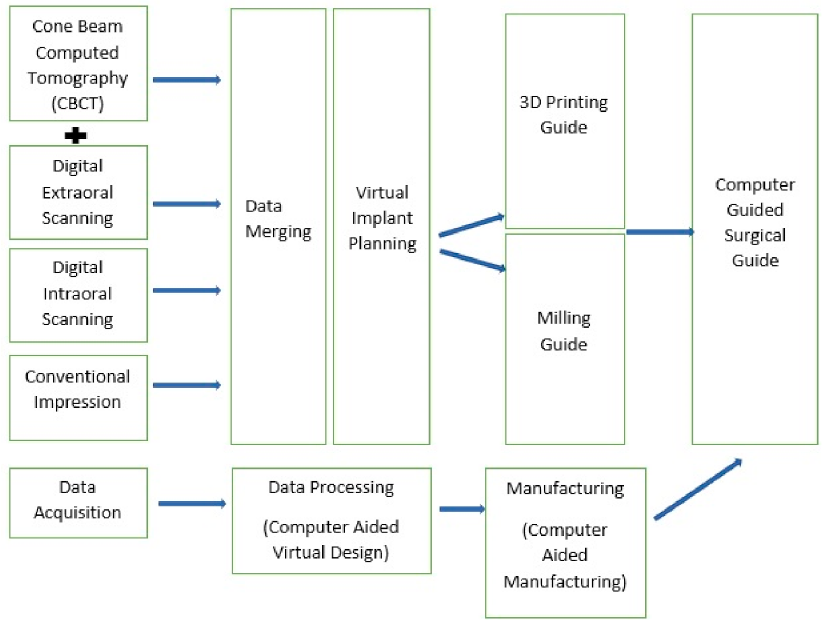
Figure 3. Schematic workflow of static guided surgery. Please note the 3D printing in the manufac- turing stage.